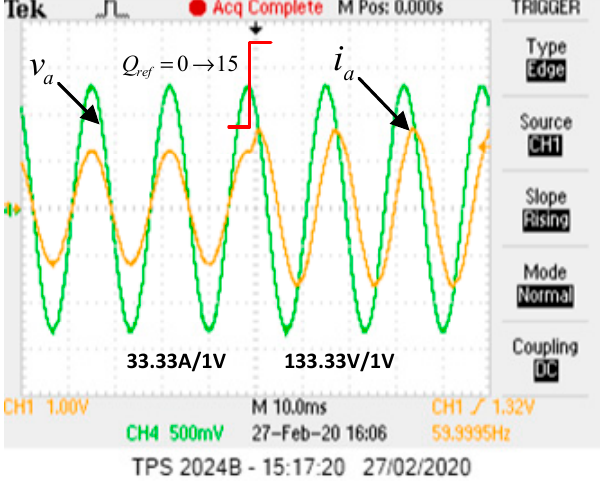
Figure 15. Voltage and current for phase A during Pref = 10 kW and transition from Qref = 0 to Qref = 15 kVar.